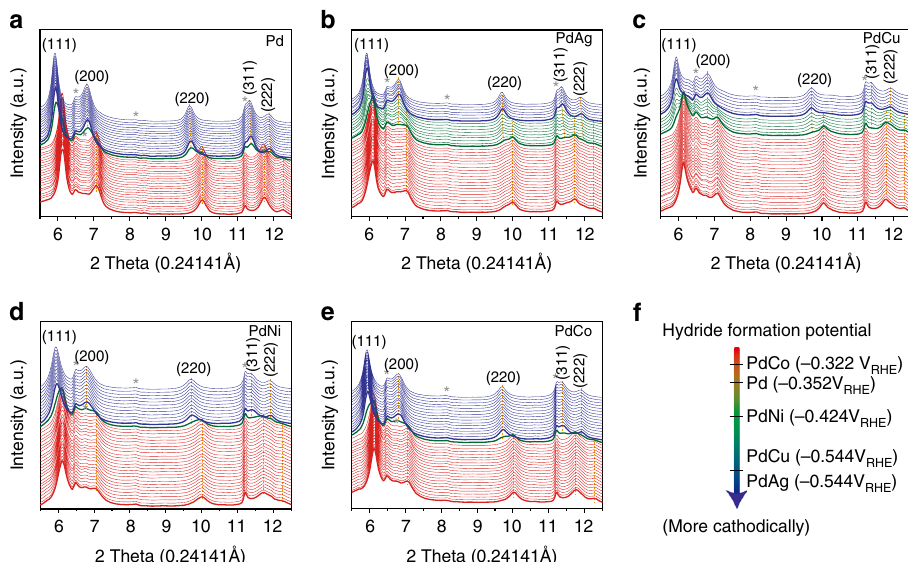
Fig. 3 In situ XRD analyses for different catalysts. In situ XRD pro fi les for a Pd, b PdAg, c PdCu, d PdNi, and e PdCo. f The schematic energy diagram illustrating their potentials of palladium hydride formation. In a – e red and blue lines indicate Pd and PdH phases, respectively. Green lines indicate their two phase regions. Asterisk (*) marks point out the peaks from the carbon